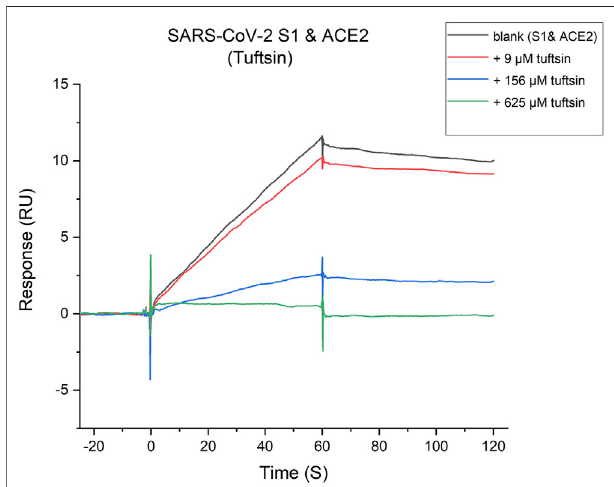
FIGURE 4 | Tuftsin inhibits the SARS-CoV-2 S1 binding to ACE2. The binding activity of SARA-CoV-2 S1-protein to ACE2 in the presence of increasing concentrations of tuftsin. The gray “ blank ” line represents the binding response of S1-protein with ACE2 alone for negative control. Then, multiple concentrations of tuftsin were added based on the “ blank ” for comparison. Intensive concentrations of tuftin showed enhanced inhibitory